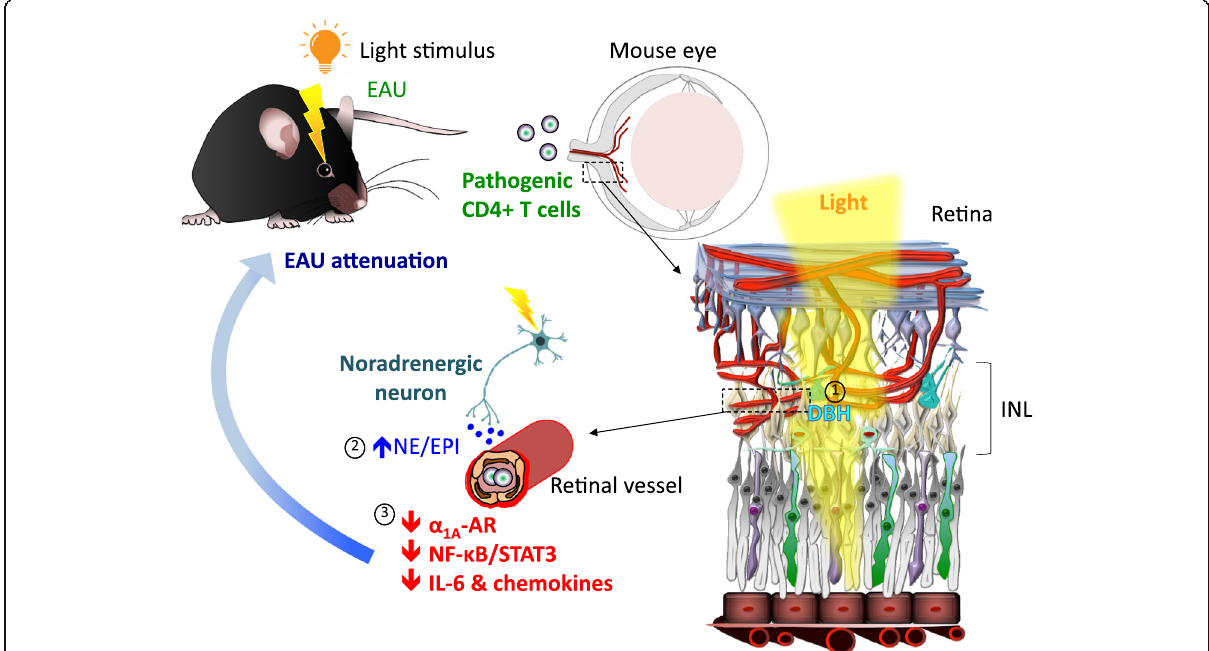
Fig. 5 Light gateway reflex. Exposure to photopic light in actively induced EAU attenuates retinal inflammation. This process is mediated through light-induced expression of DBH, an enzyme essential for the synthesis of NE and EPI, by retinal neurons located in the INL (1). The increased NE and EPI levels down-regulate retinal α 1A AR expression, which is followed by reduced NF- κ B and STAT3 activation and decreased chemokine and IL-6 expressions in the retina (2)(3). This protects the BRB integrity and suppresses recruitment of immune cells including IRBP-specific pathogenic CD4+ T cells in the retina. Abbreviations: EAU, experimental autoimmune uveoretinitis; DBH, dopamine beta-hydroxylase; INL, inner nuclear layer; NE, norepinephrine, EPI: epinephrine; α 1A AR, alpha-1A adrenoceptor; BRB, blood-retina barrier; IRBP, interphotoreceptor retinoid-binding